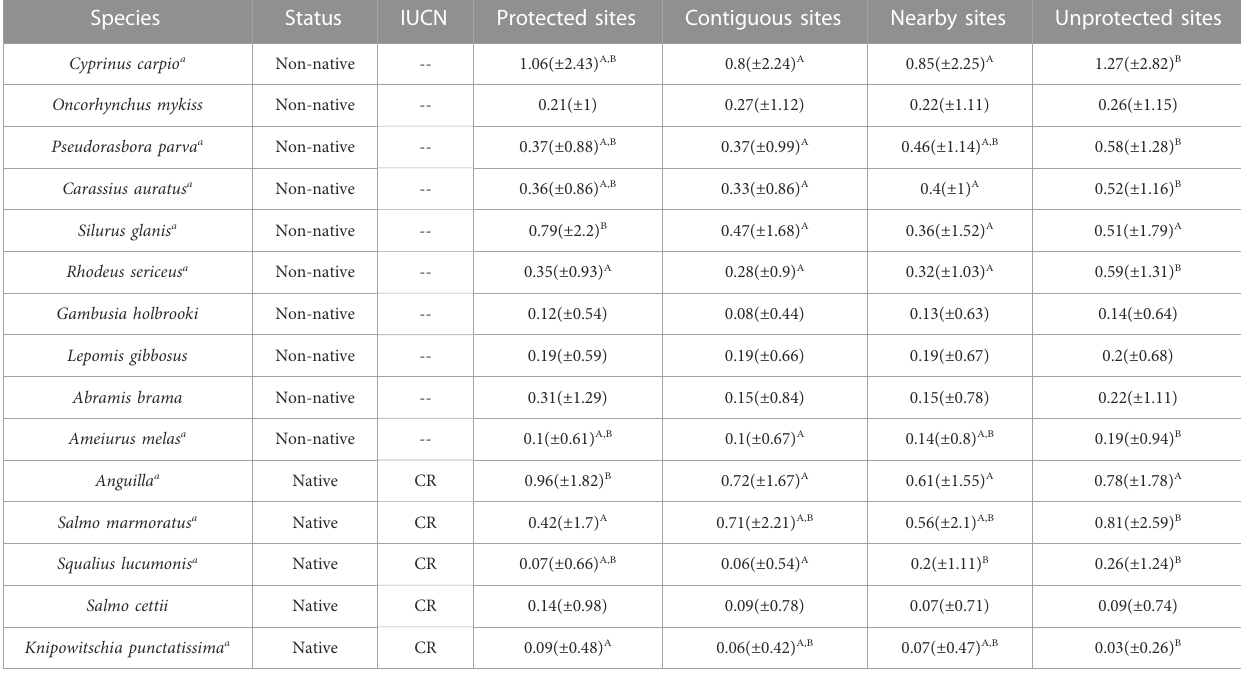
TABLE 2 Mean abundance (Moyle classes) and standard deviation of fi sh species in sites in Protected, Contiguous, Nearby and Unprotected sites. The status of non-native (i.e. top 10 invasive species) and native and the IUCN class (CR = Critically endangered) are reported for each species.